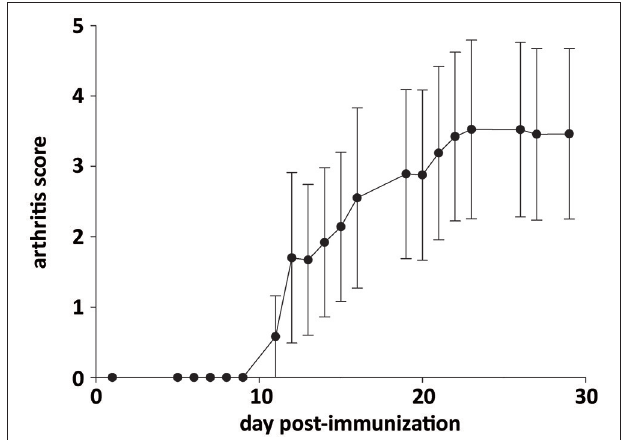
TABLE 1 | AIA-induced changes in the BDNF pathway and endothelial NO production do not relate to the severity of inflammatory symptoms. Vascular BDNF levels/athritis score serie 1 − 0.005 0.993 Vascular BDNF levels/arthristis serie 2 − 0.653